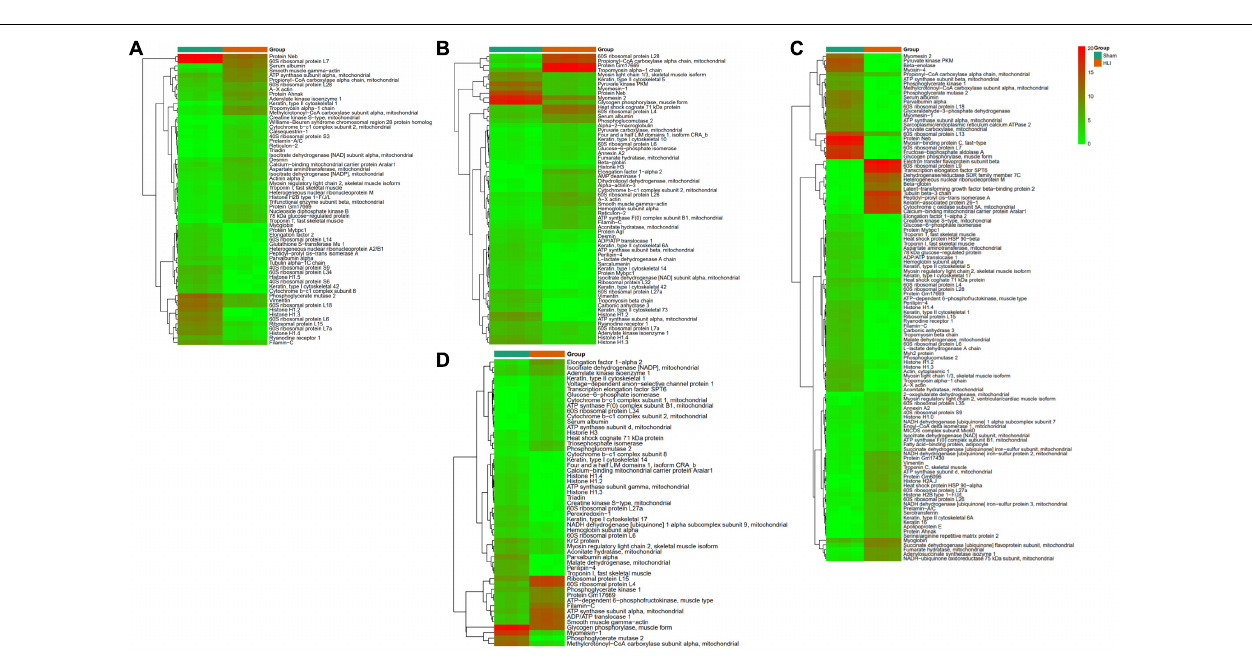
FIGURE 5 | Volcano plot showing the differentially expressed proteins at each time points. Proteins with statistically significant differential expression ( ≥ 1.5-fold, p < 0.05) at days 1 (A) , 3 (B) , 7 (C) , and 14 (D) located in the top right and left quadrants. Red dots indicate up-regulated proteins (ratio > 1.5, p < 0.05), green dots indicate down-regulated proteins (ratio < 0.67, p < 0.05).